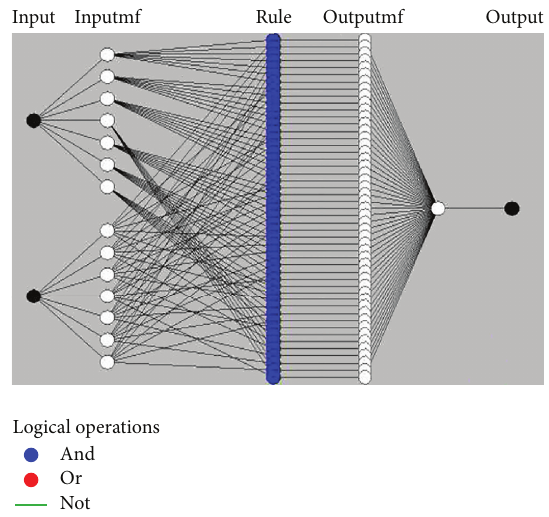
Figure 4: ANFIS model structure with two inputs and one